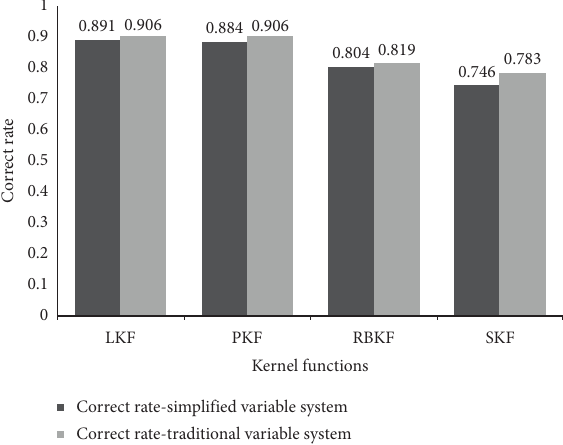
Figure 3: Correct rate of two SVM models based on each kernel